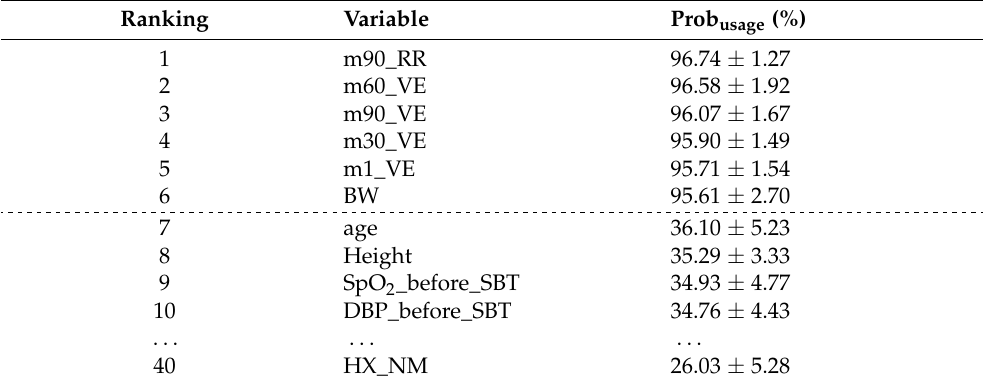
Table 6. Usage probabilities of the top 10 variables. The first 6 variables have significant higher prob- abilities. Ranking Variable Prob usage